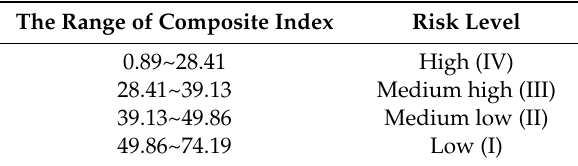
Table 7. Assessment